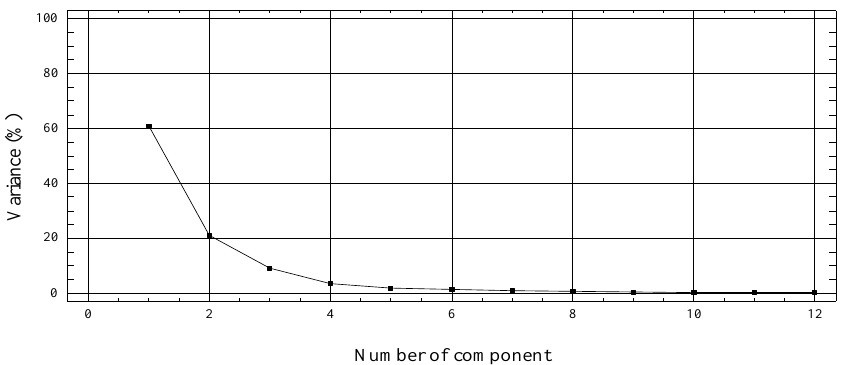
Figure 2. Scree plot visualization: The dependence between the number of principal components and % of explained variance.